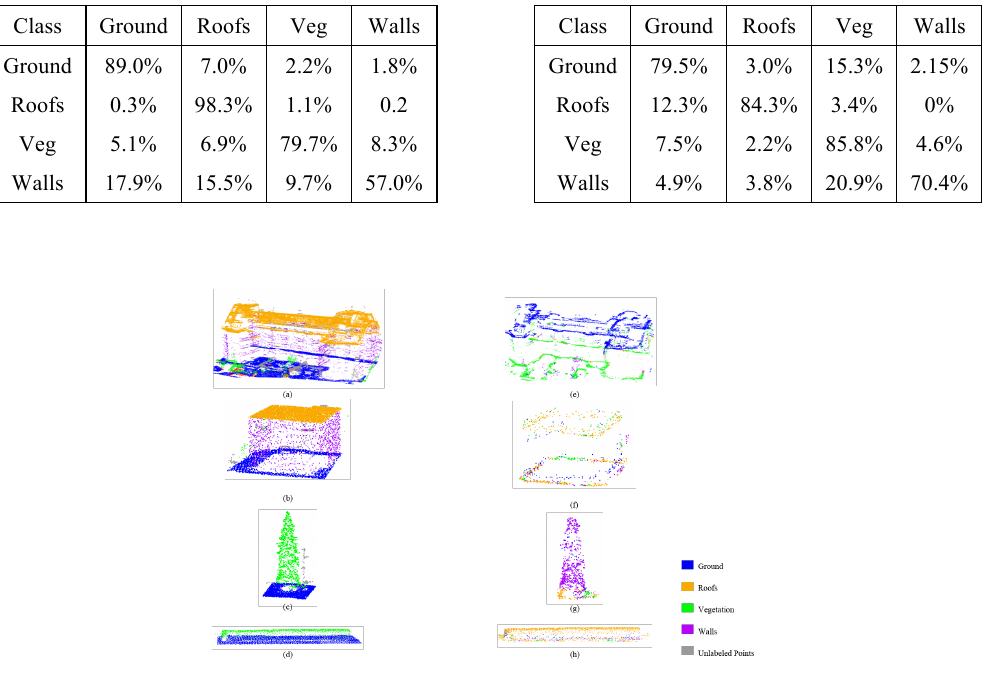
Figure 3. Reference and misclassified point in 4